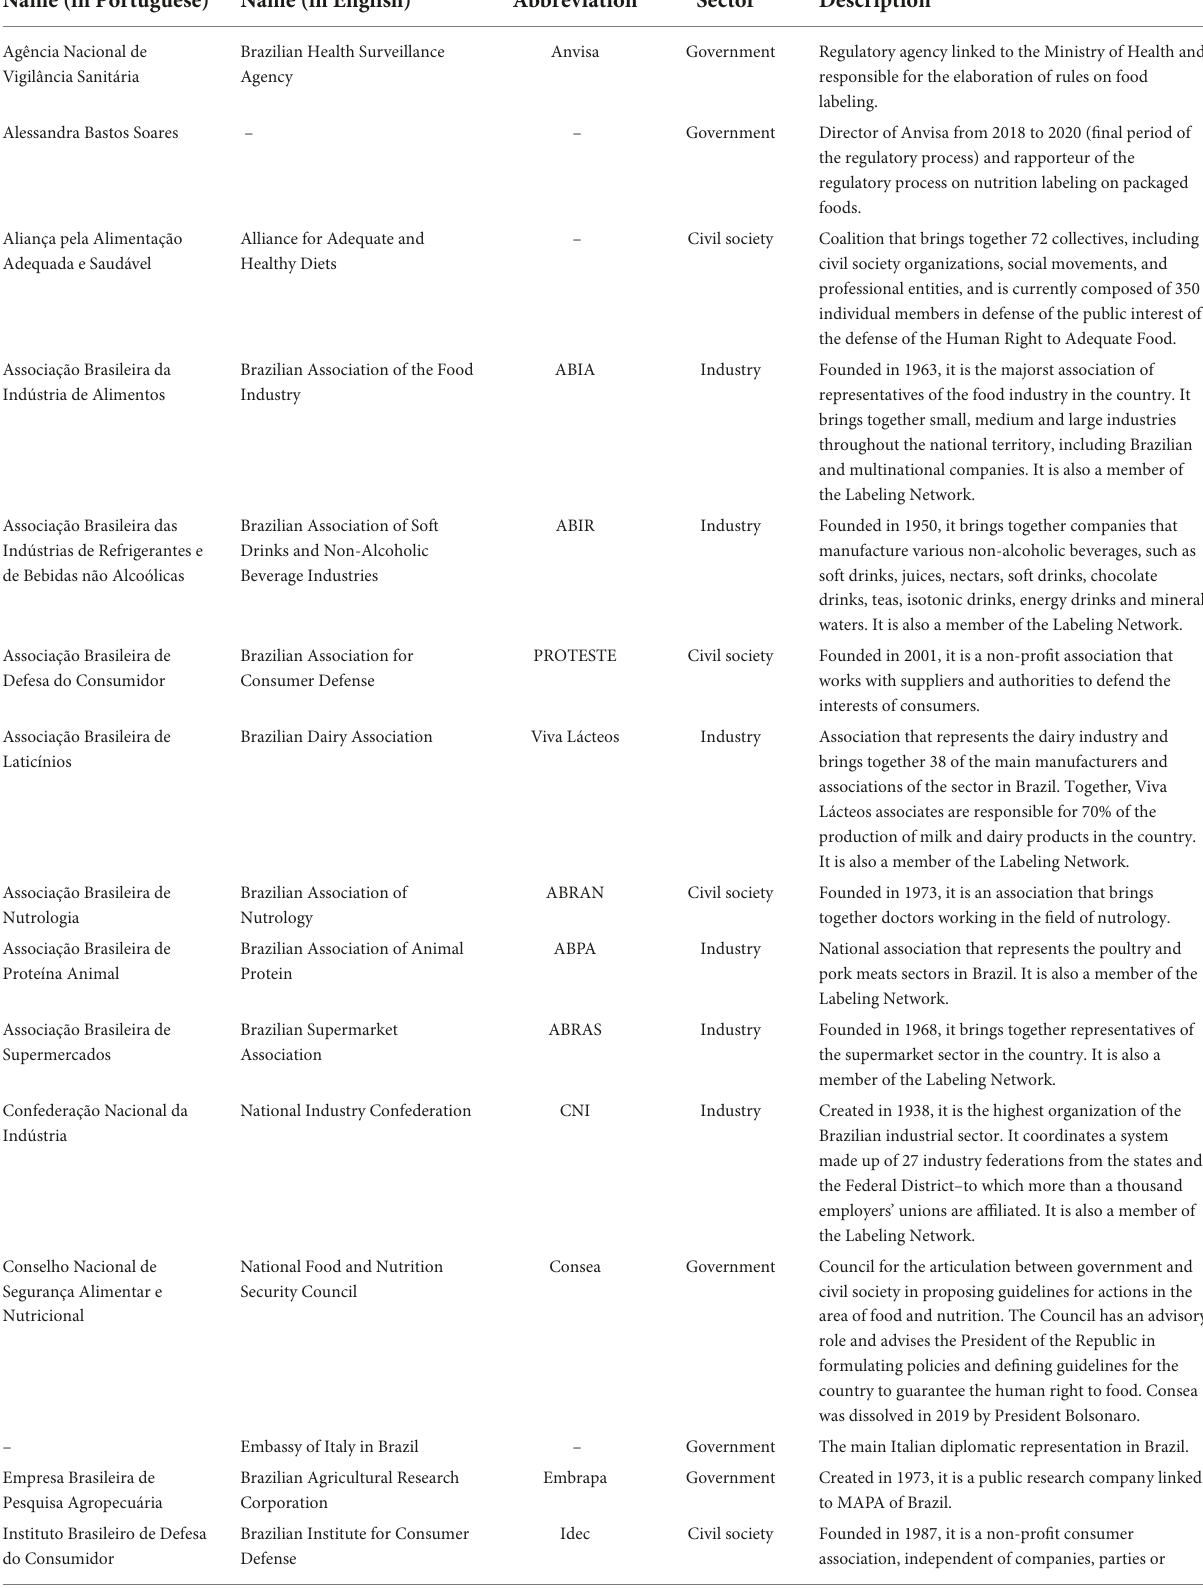
TABLE 2 Actors involved in the regulatory process of nutrition labeling of packaged